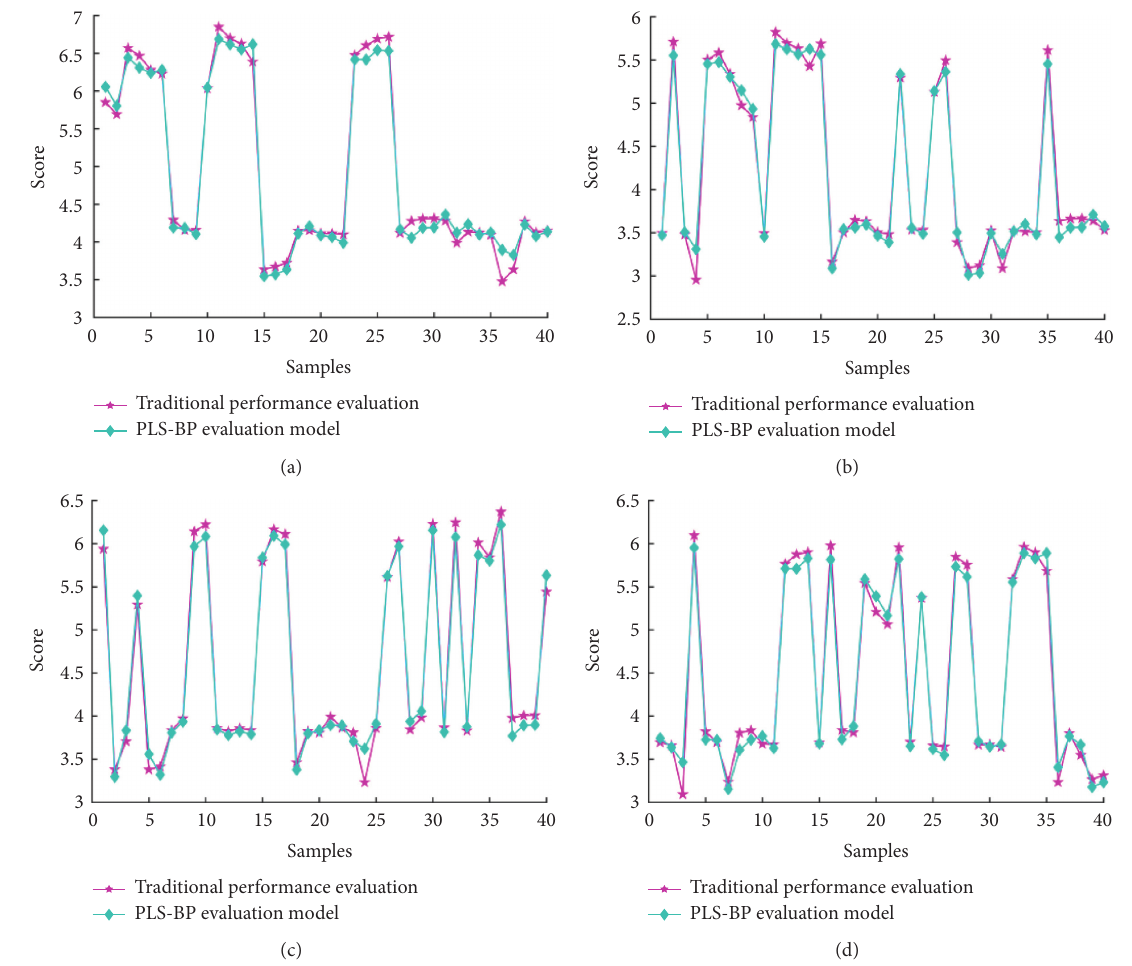
Figure 6: Comparison results of performance score: (a) University 1; (b) University 2; (c) University 3; (d) University 4.